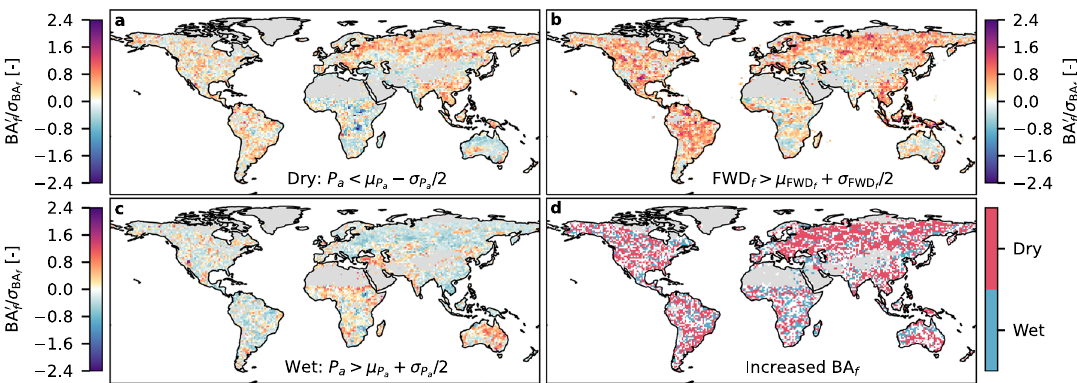
Fig. 2 Relationship of burned area to fi re weather and precipitation. a Annual normalised burned area anomalies, ð BA f Þ 0 = σ BA indicate anomalies), for 2001 – 2019, averaged over dry antecedent years, de fi ned as when P a < μ P years satisfy this threshold. b As in a but for years of heightened fi re weather, de fi ned as when FWD f > μ FWD þ σ = 2 . d Grid cells for which burned area anomalies increase when wet (blue; c ) or dry (red; a ) years compound antecedent years, P a > μ P P a a with years of heightened fi re weather ( b ). White indicates no increase in burned area from compound dry or wet years. There are typically only one to three of these compound years, but results are robust when computed with smaller departures from the mean e.g. using μ ± σ